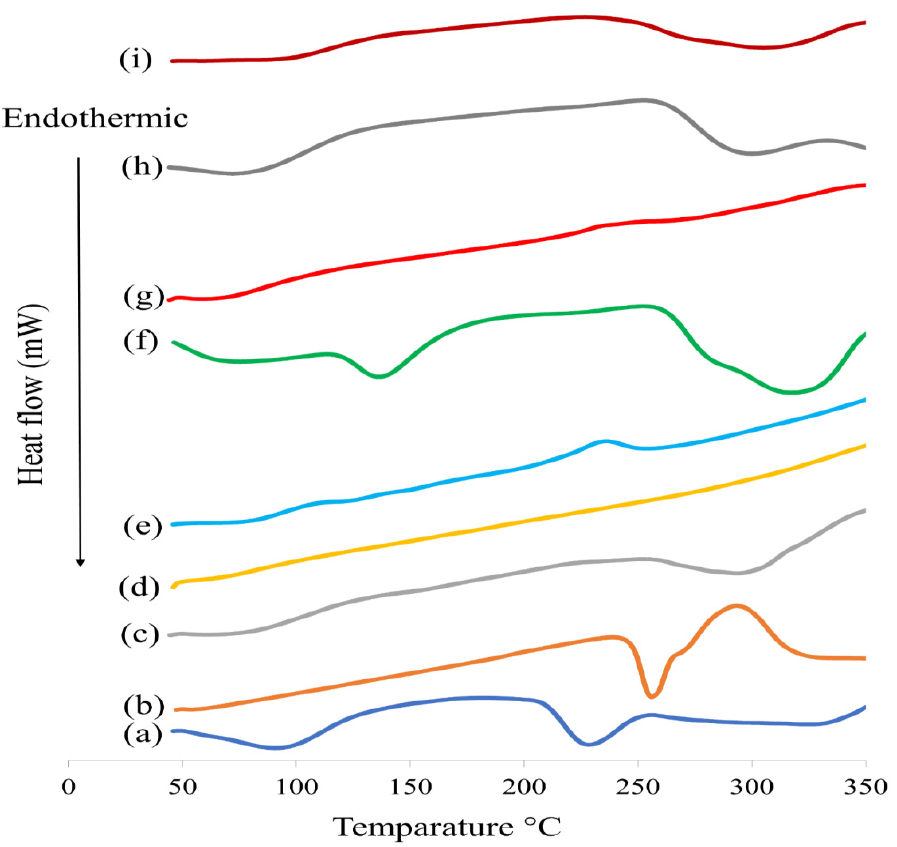
Figure 6. DSC thermograms of ( a ) pitavastatin, ( b ) tedizolid, ( c ) zein, ( d ) BGT 5 , ( e ) sodium hyaluronate, ( f ) physical mixture of D-ZIFI 1, ( g ) the implant of D-ZIFI 1, ( h ) physical mixture of D-ZIFI 2, and ( i ) implant of D-ZIFI 2.